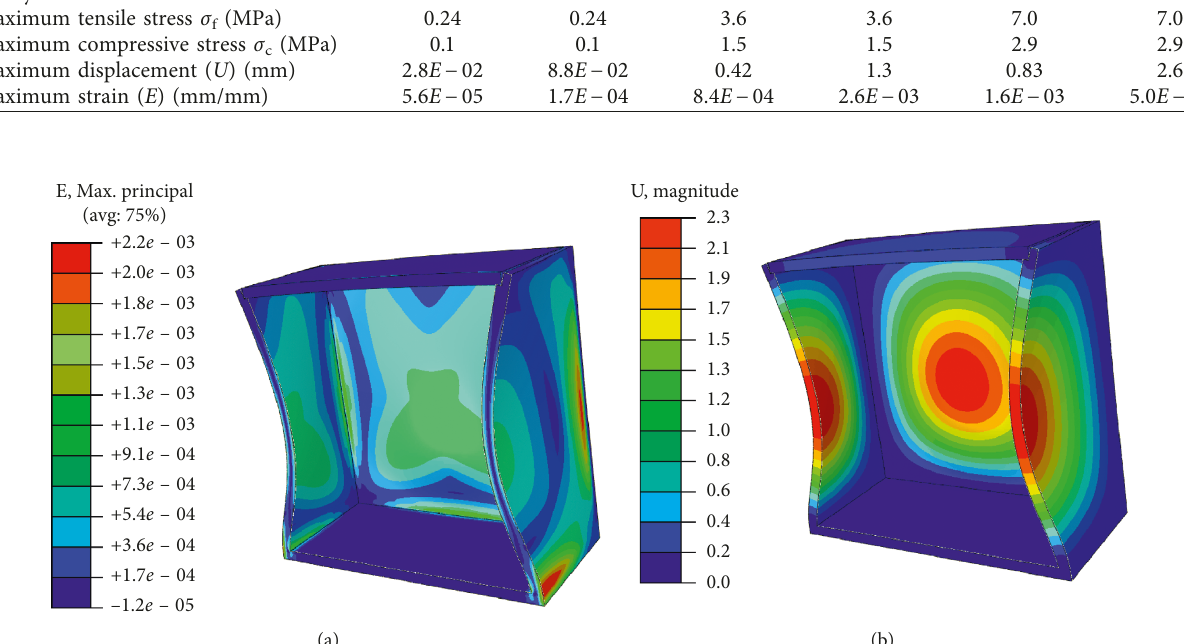
Table 7: Simulation results for Utility Structure 1 and Utility Structure 2 with a wall thickness of 50mm as a function of soil pressure. Pressure (kPa) Maximum tensile stress σ f (MPa)